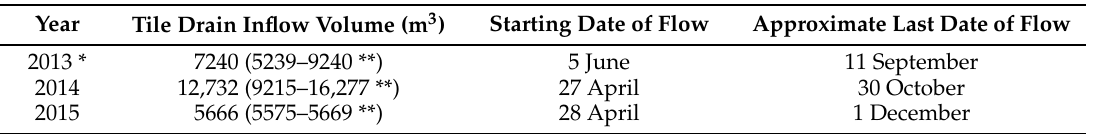
Table 3. Volume of water flowing into the wetland from tile drainage each year of the study. The flow period is also listed by start and end dates each year.